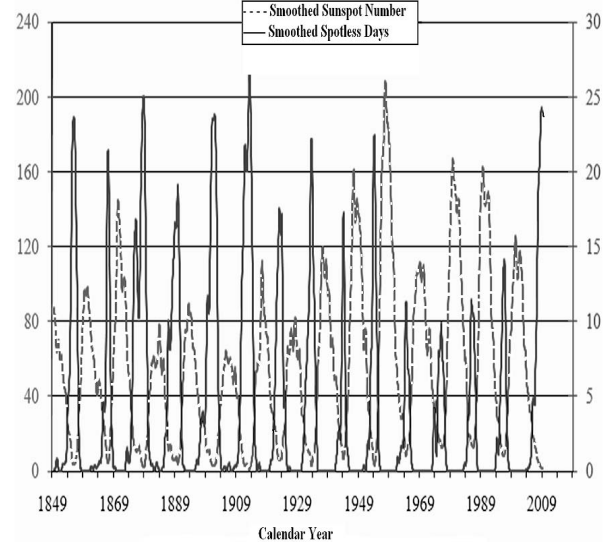
Fig. 1. The number (the filled squares) of spotless days in solar cycles 10 to 24. Fig. 2. The smoothed monthly number of spotless days (solid line, right scale) and smoothed monthly sunspot number (dashed line, left scale). The data used here are available from the spotless-day web site